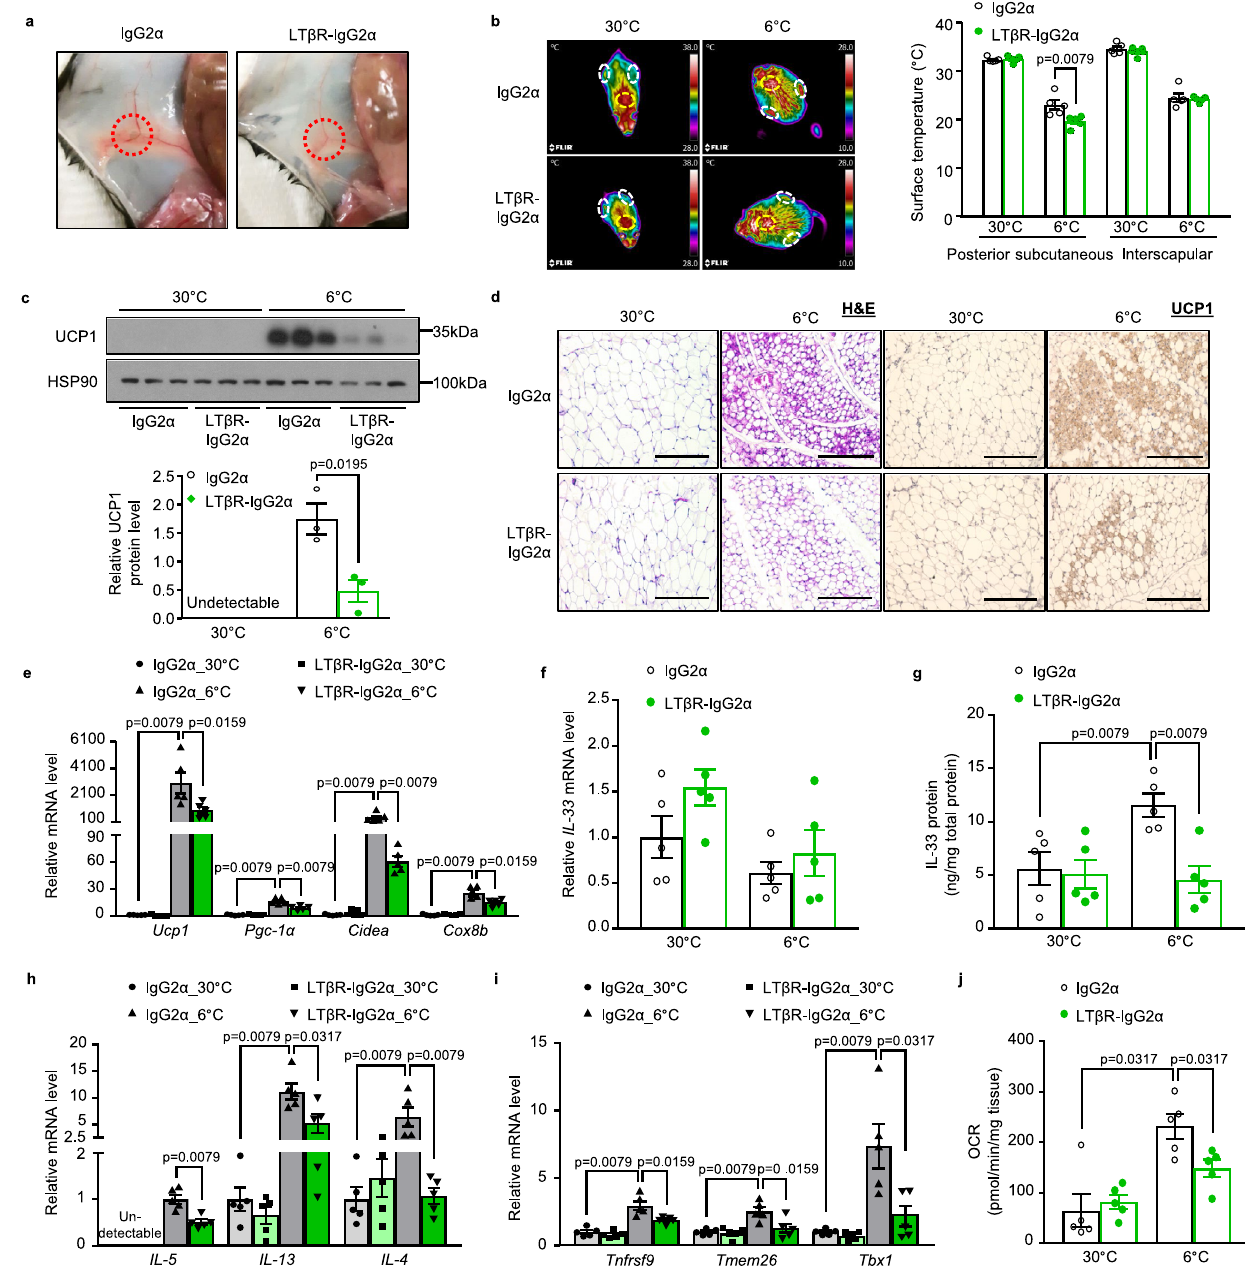
Fig.7|LT β R-IgG2 α -induceddepletionofiLNsimpairsbeigingofscWATduring cold exposure. Pregnant female C57BL/6N mice were intravenously injected with lymphotoxin beta receptor-immunoglobulin G2 α fusion protein (LT β R-IgG2 α ) (200 μ g) on embryonic day 13 (E13) and E14 to generate iLN-depleted progeny mice. Mice receiving IgG2 α isotype were used as controls. a Macroscopic photos showing the absence of iLN in LT β R-IgG2 α -treated mice (red-dotted circle). b RepresentativeinfraredimagesofiLN-depletedmiceandtheircontrolshousedat 30°C or 6°C (left), and the quanti fi cation of average surface temperature in the posterior subcutaneous (white-dotted circles) and interscapular regions (yellow- dotted circle) (right) ( n =5). c UCP1 protein expression in scWAT (top) and densi- tometric analysis for the relative abundance of UCP1 normalized with HSP90